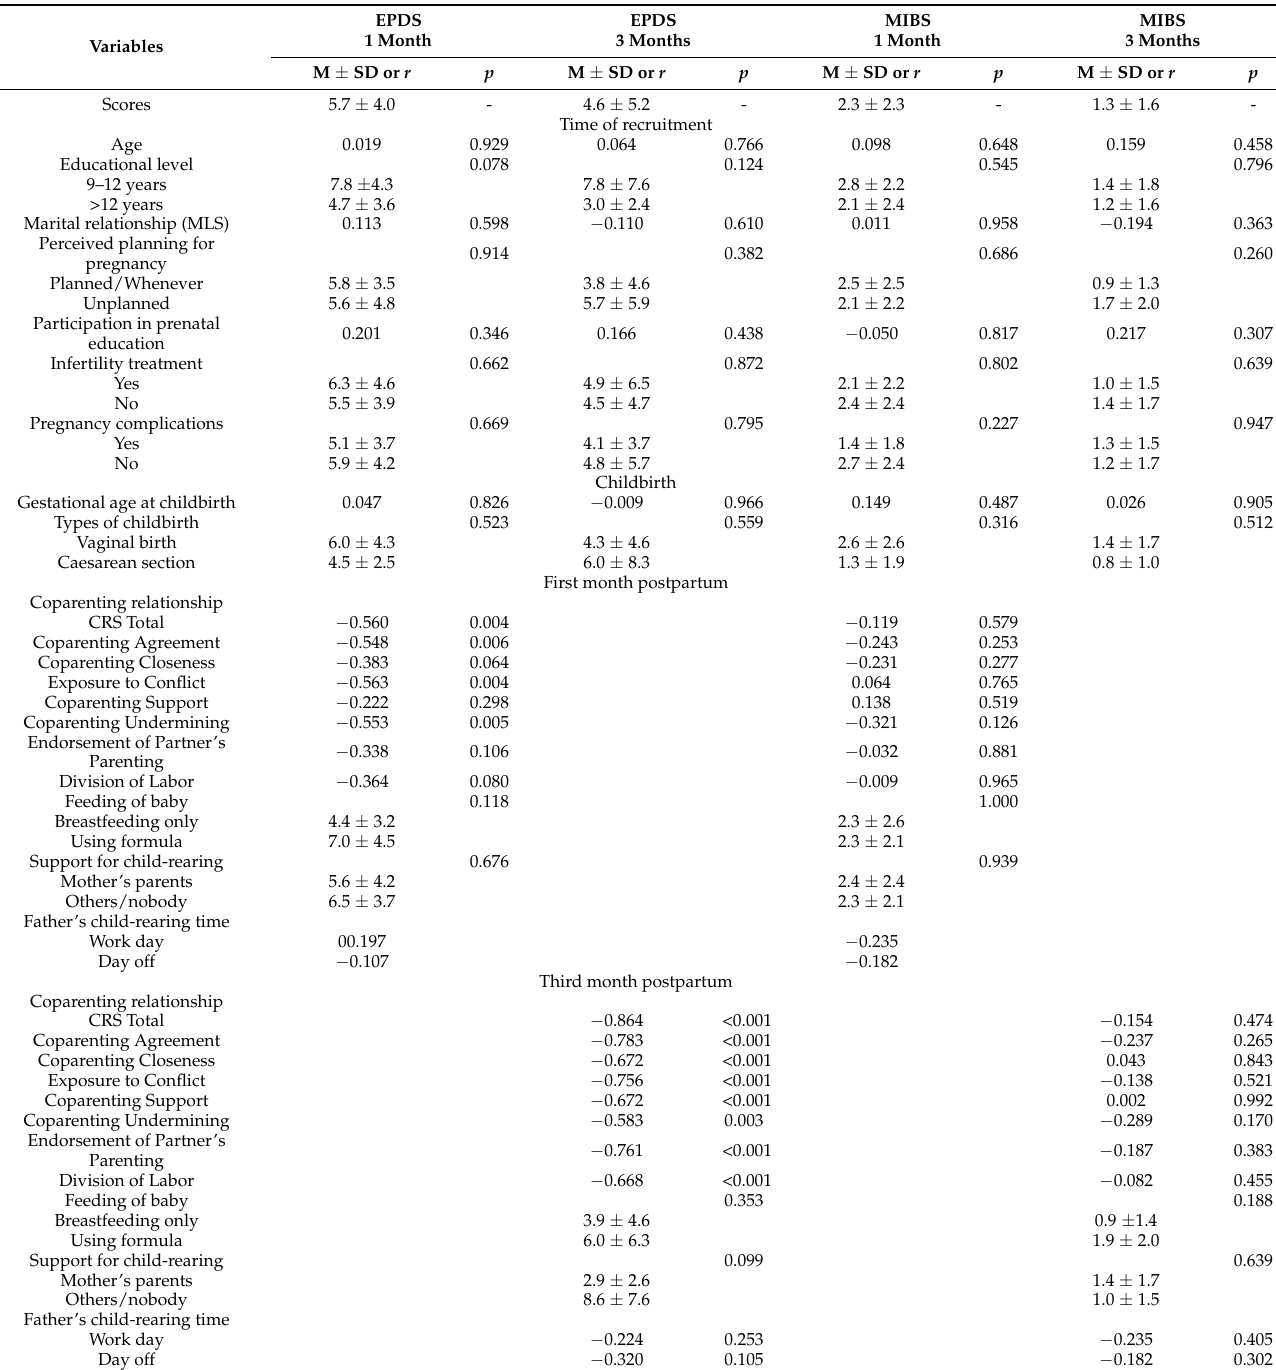
Table 2. Comparison of childrearing and parental mental health at one and three months after